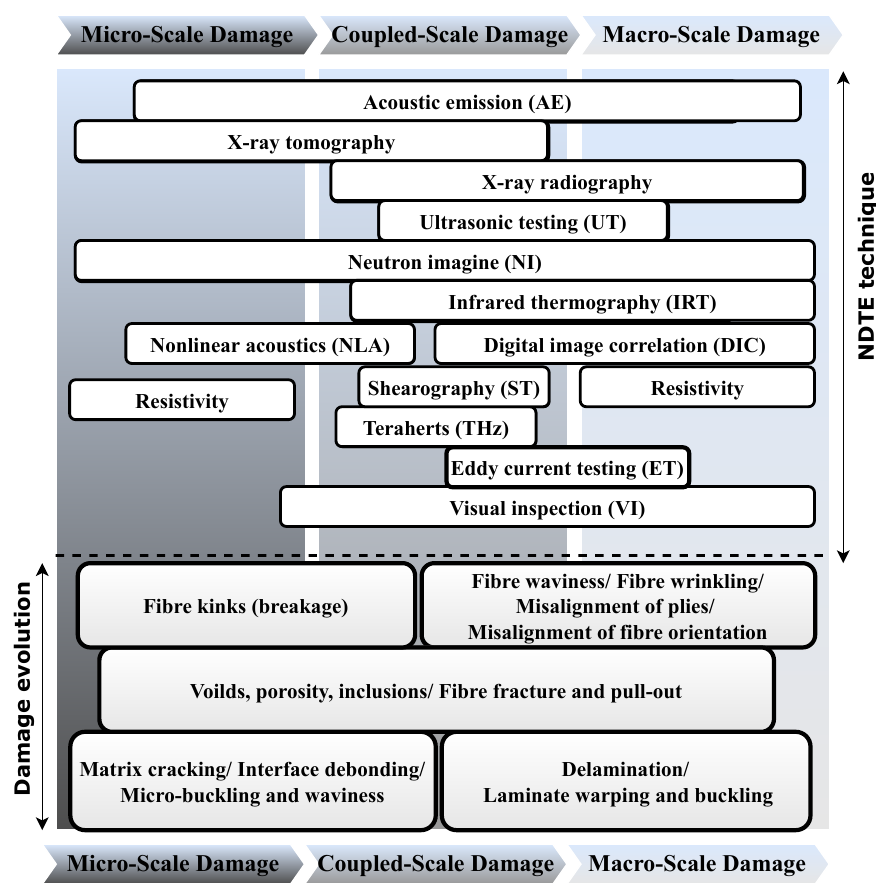
Figure 4. Categories of different non-destructive testing and evaluation techniques (NDTE).